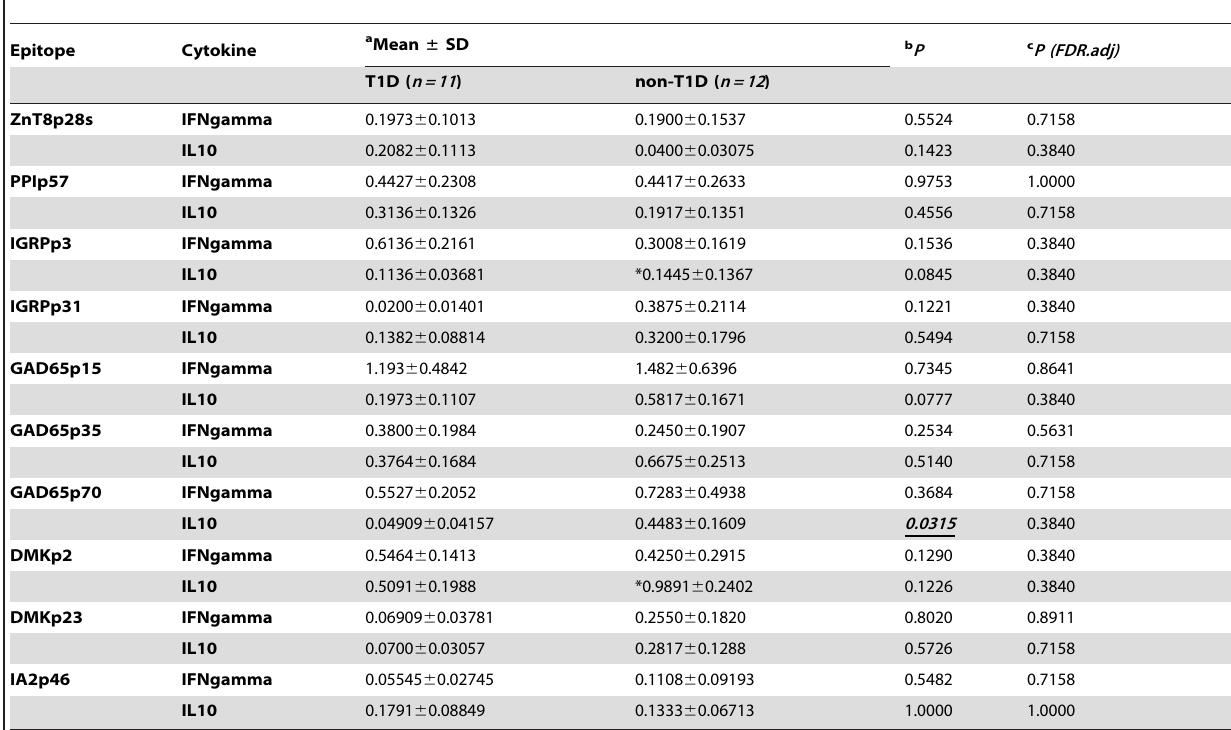
Table 3. Beta-cell epitope specific T cell